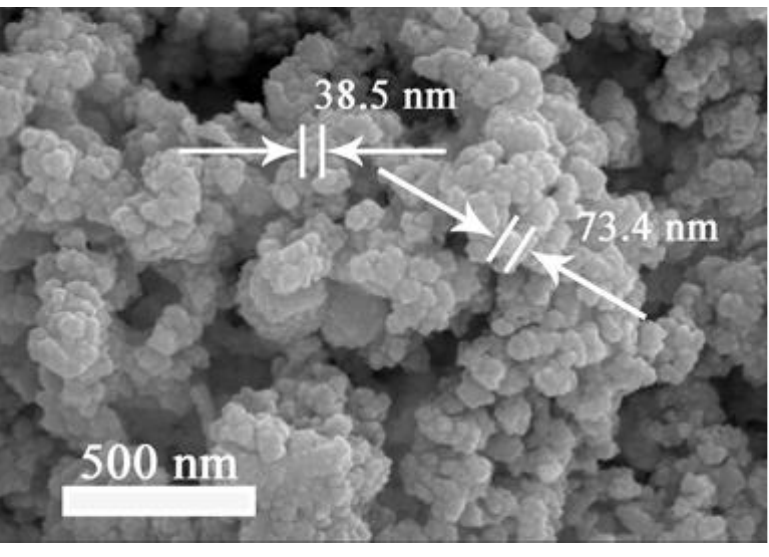
Figure 2. SEM images of CS/1NC@3.